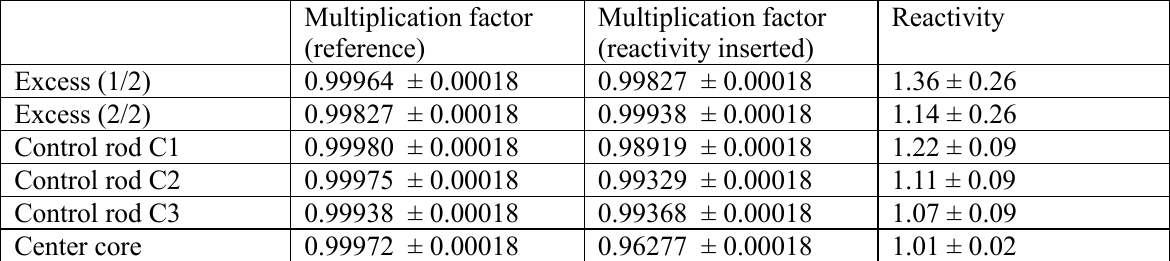
Table VI. C/E value of multiplication factor and reactivity with JEFF3.2: Errors correspond to